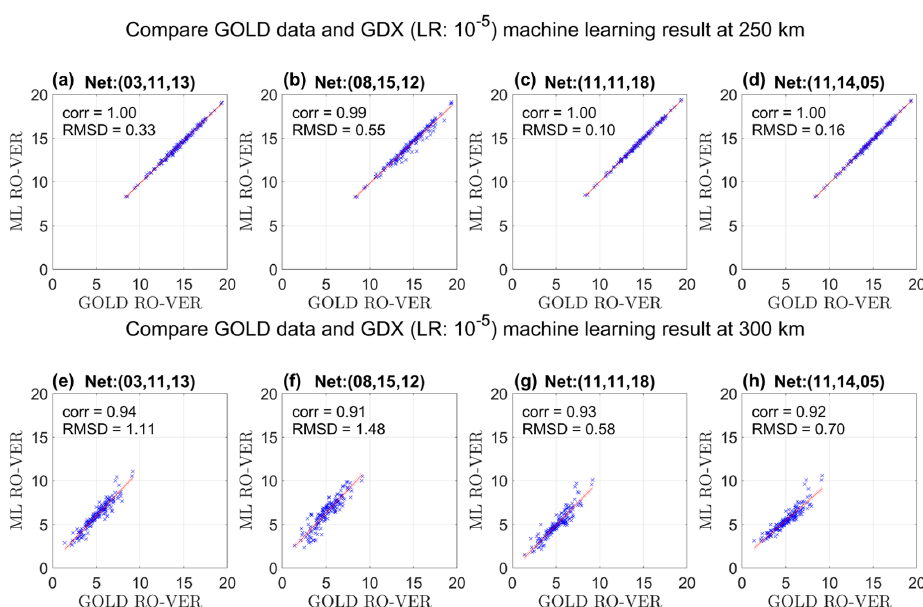
Figure 4. Scatter plots of the four top-performing nets trained with GDX algorithm in the comparison of RO-VER at ( a – d ) 250 km and ( e – h ) 300 km between randomly subsampled 320 profiles of VERs retrieved from GOLD limb intensity (GOLD RO-VER) and machine learning topside profiles (ML RO-VER). The linear regression is indicated as a red solid line. The correlation coefficient and root- mean-square deviation (RMSD, unit: VER) of each scatter diagram are noted on the top left of each subplot. From left to right, the nets with the number of neurons in three hidden layers (HDL) are (03, 11, 13), (08, 15, 12), (11, 11, 18), and (11, 14,